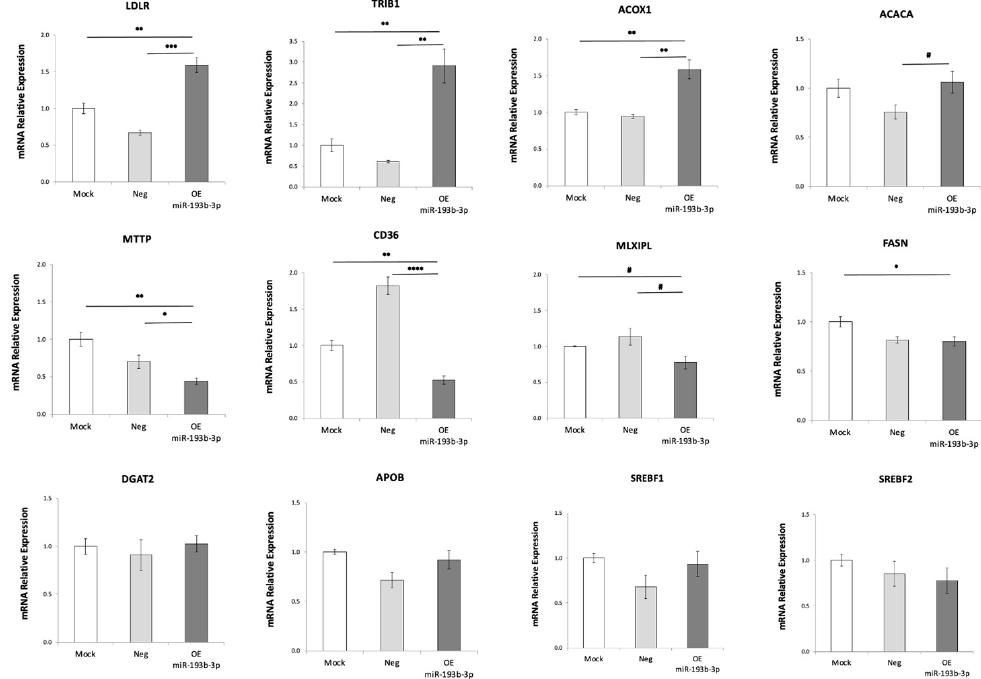
Figure 3. Overexpression of microRNA hsa-miR-193b-3p in HepG2 alters mRNA expression of fundamental genes involved in lipid processing. Lower mRNA expression of MTTP and higher expression of TRIB1 suggest reduced VLDL secretion. Higher level of LDL receptor LDLR . No change in APOB . Lower mRNA level trend of MLXIPL /ChREBP, coordinating triglyceride synthesis. No change in DGAT2 , SREBF1 (n = 3) or SREBF2 (n = 3). Lower expression of fatty acid synthase ( FASN ) (I). No change in ACACA . Increased ACOX1 indicates increased fatty acid oxidation. Reduced fatty acid translocase CD36 . Relative mRNA expression was evaluated by real-time RT-qPCR after 72 h overexpression of hsa-miR-193b-3p in HepG2 cells under hyperglycemia/hyperinsulinemia (20 mM glucose, with 10 nM insulin during last 24 h). Data are presented as mean ± SEM of n = 4, unless otherwise indicated. Mock—mock transfection, OE—overexpression of hsa-miR-193b-3p. Student’s t -test p -values indicated by # < 0.1, * < 0.05, ** < 0.01, *** < 0.001 or **** <